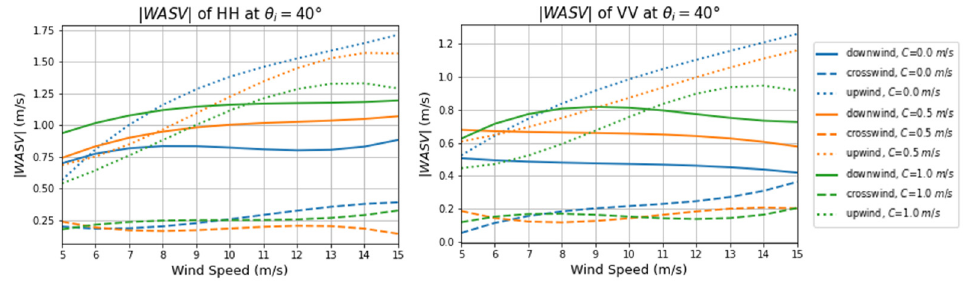
Figure 9. The relationship between WASV magnitude and wind speed for HH and VV polarizations.